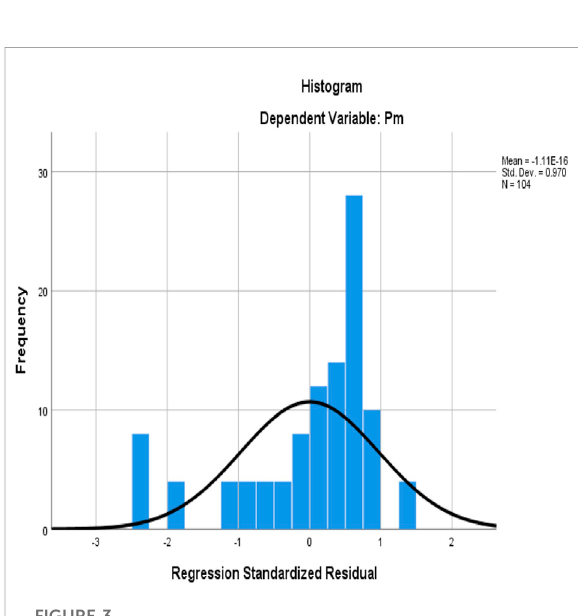
FIGURE 3 Histogram corresponding to the dependent variable for